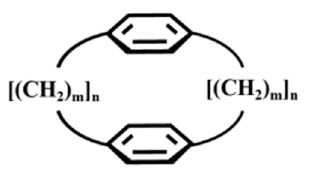
Figure 1. The structure diagram of [m n ]cyclophane (m = n = 3–6).